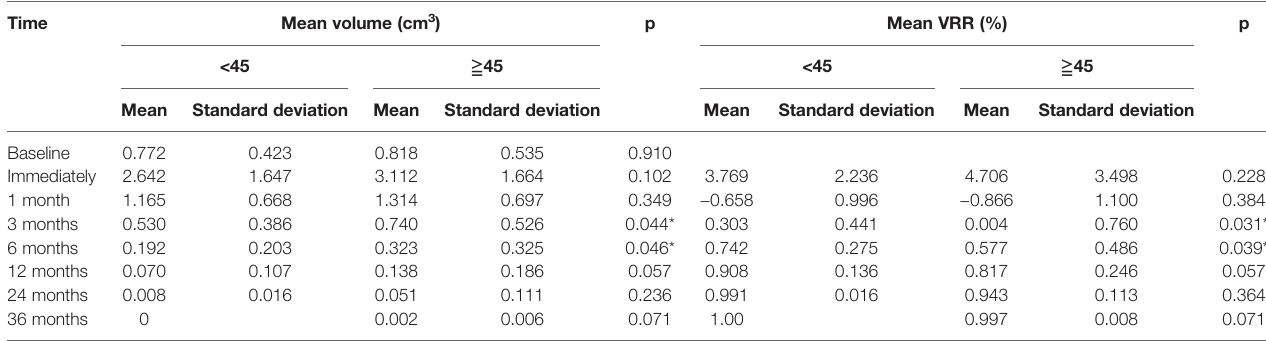
TABLE 3 | Changes in nodules volume and VRR in both age groups over the study period.